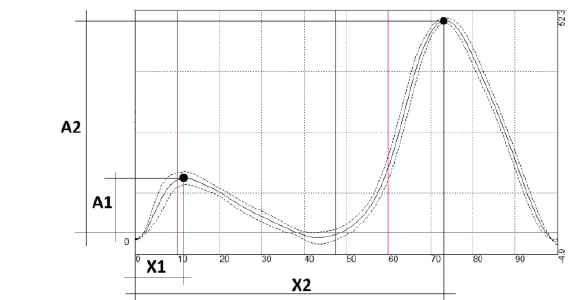
Table 2. Temporal parameters of gait cycle and impact amplitude at the start of the stance phase. Parameter